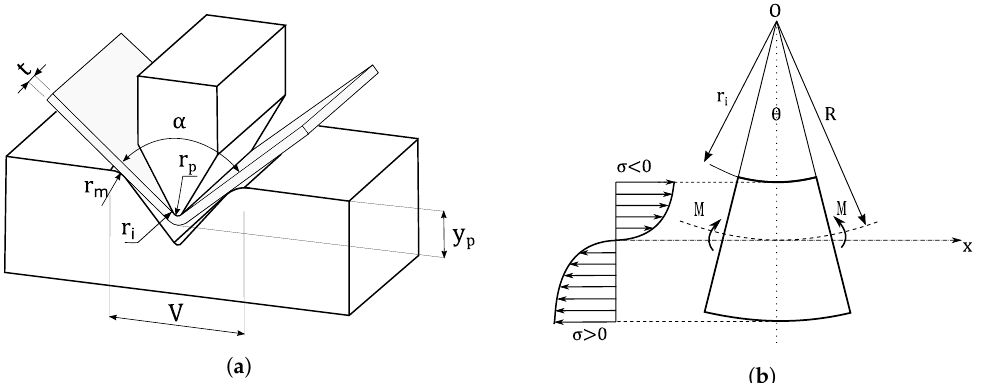
Figure 1. ( a ) Air bending process parameters: die opening ( V ), die radius ( r m ), inside bending radius ( r i ), punch nose radius ( r p ), punch penetration ( y p ), sheet bending angle ( α ), sheet thickness ( t ); ( b ) stress distribution in plastic bending